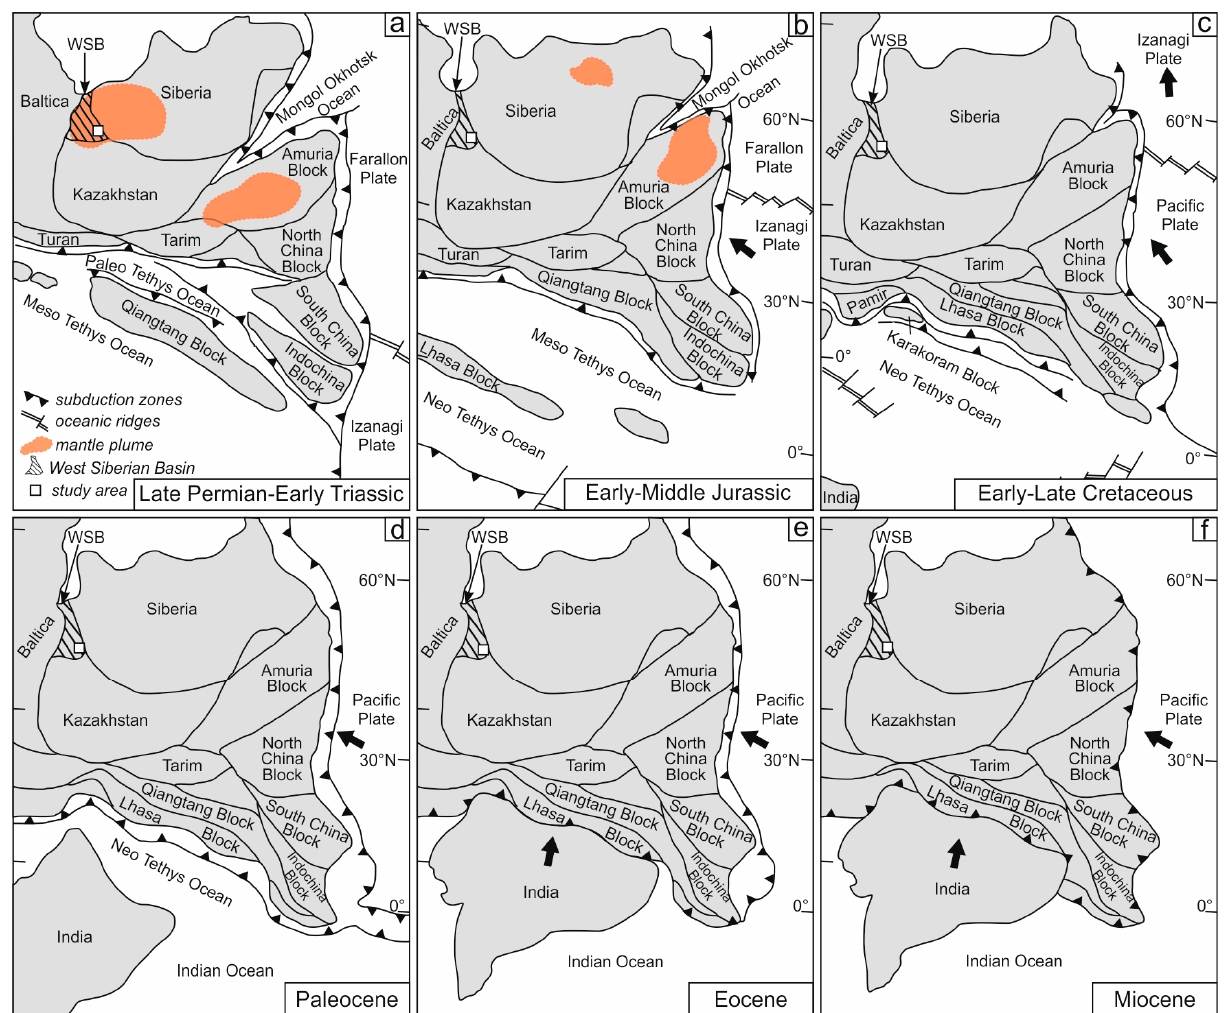
Figure 9. Simplified paleo-tectonic maps (after [73,88,89]) illustrating the position of the various continental blocks and oceanic plates from the Late Permian – Early Triassic to the Miocene ( a–f ).